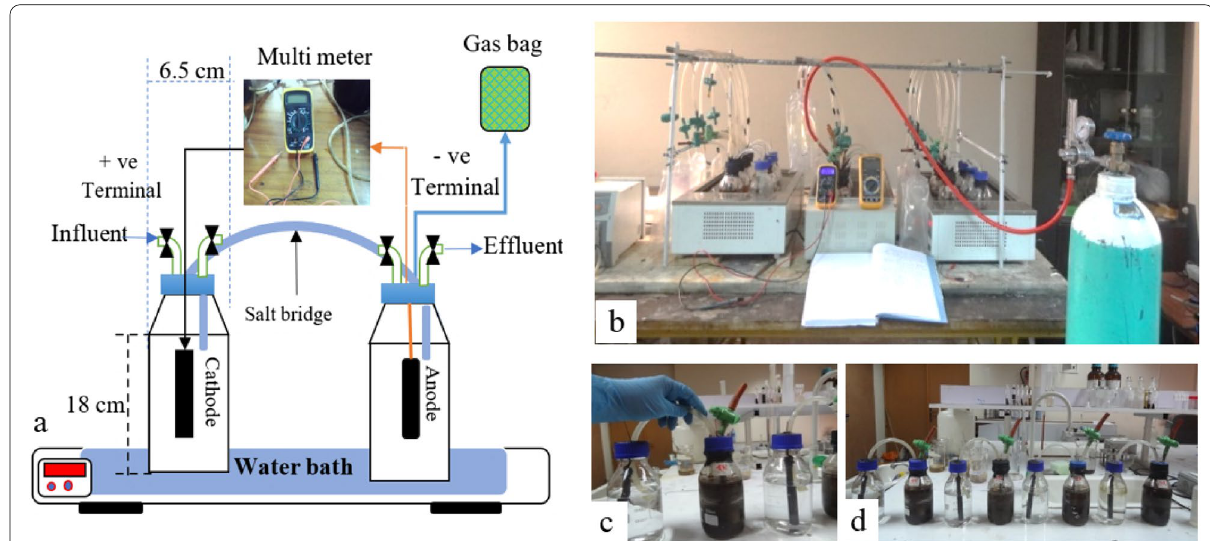
Fig. 1 Double-chambered FAB-MFC optimization setup a schematic diagram, b photo, c , d during the construction of the reactors. The cylinder is the N 2 gas sparged into the anode reactors and hardcover laboratory notebook to record the